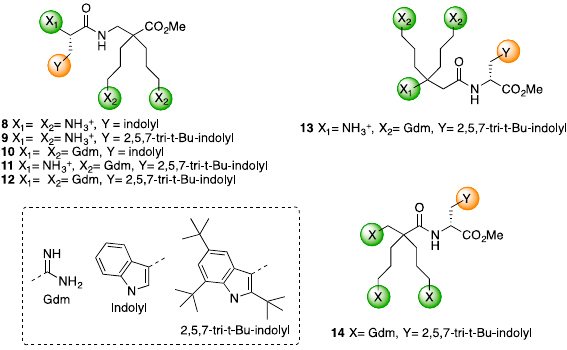
Figure 3. Structure of polycationic dipeptides 8 – 14 .